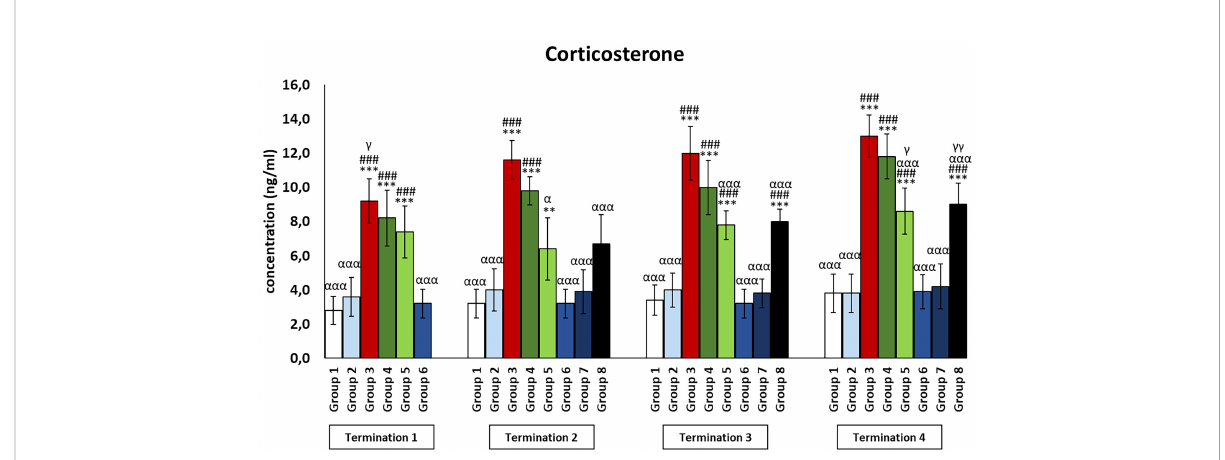
FIGURE 8 Changes in the levels of corticosterone in the blood of chickens receiving phage therapy or antibiotic therapy after 6, 20, 28, and 34 days of experiments. Results are presented as mean values ± SD. Statistical analyses were performed by Kruskal – Wallis test and post-hoc Dunn test or ANOVA and post-hoc Tukey ’ s test. The signi fi cance of differences between controls and particular treated groups is observed and marked by the following: asterisks (*) vs. saline control; (#) vs. phage control (group 2); (a) vs. infected control (group 3); (g) vs. termination 2. p < 0.001 (***, ###, aaa ), p < 0.01 (**, gg ), and p < 0.05 ( a , g